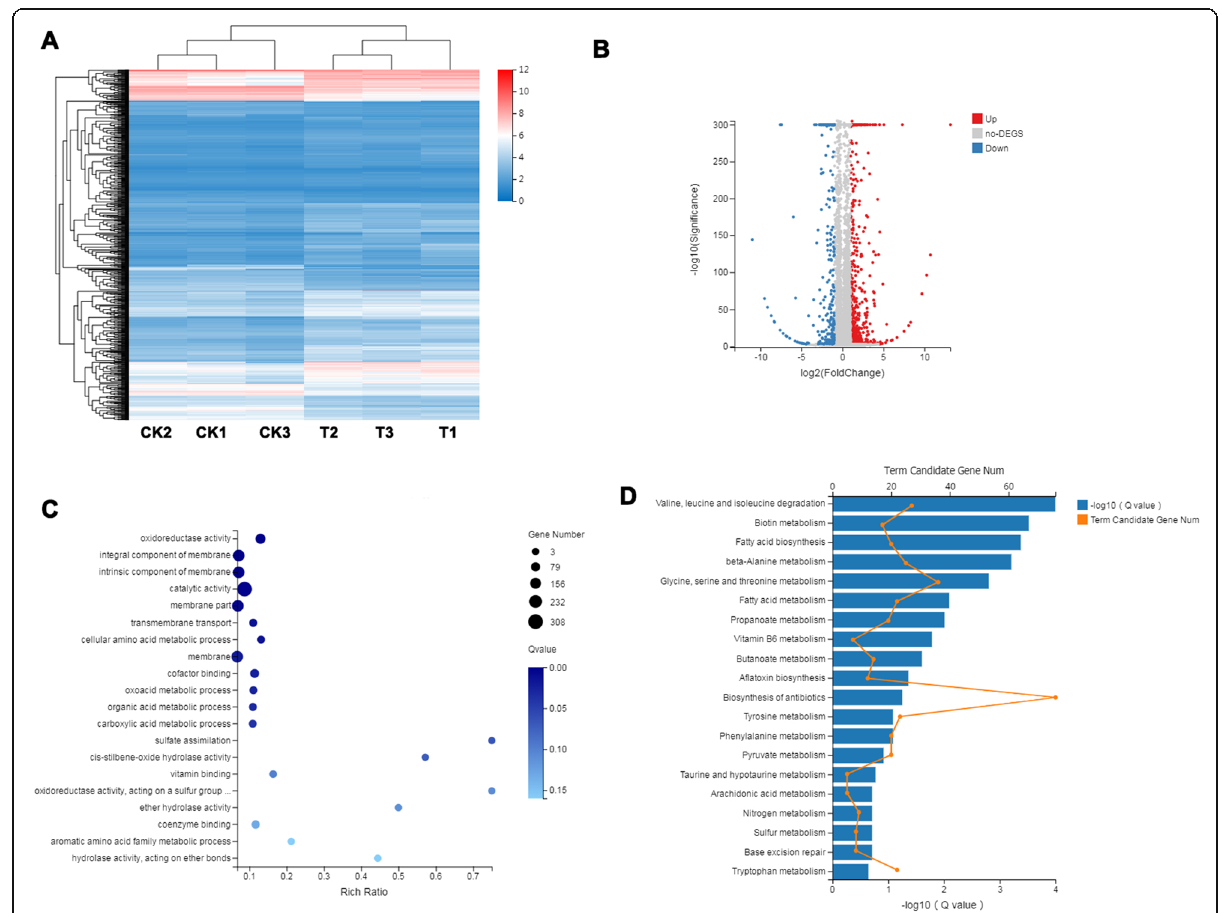
Fig. 4 Gene transcriptional profiling of F. graminearum treated with 0.5% (w/v) MG for 24 h. A Hierarchical clustering analysis showing the relationship of the gene expression among different samples according to RNA-seq analysis. B Volcano plot showing the differentially expressed